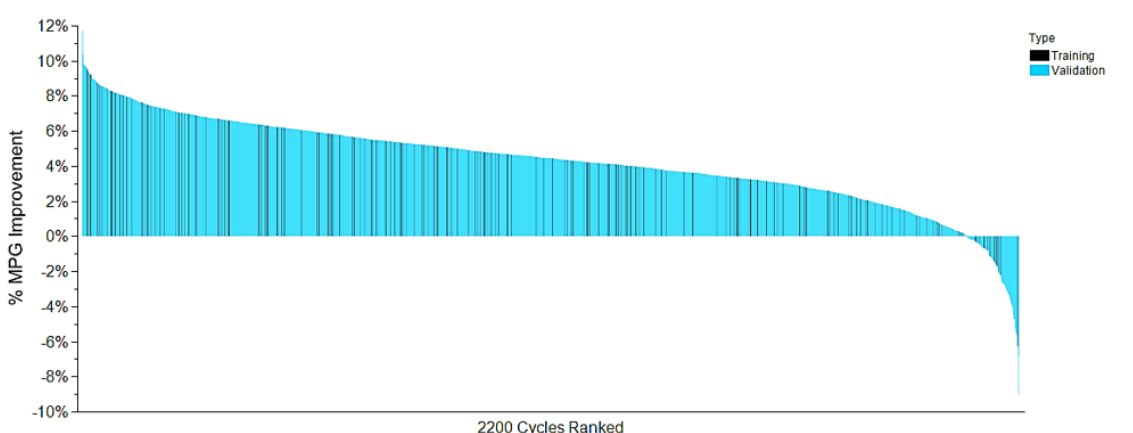
Figure 7. General NE Controller MPG % improvement over the Base Conventional controller across the training (in black) and validations cycles (in